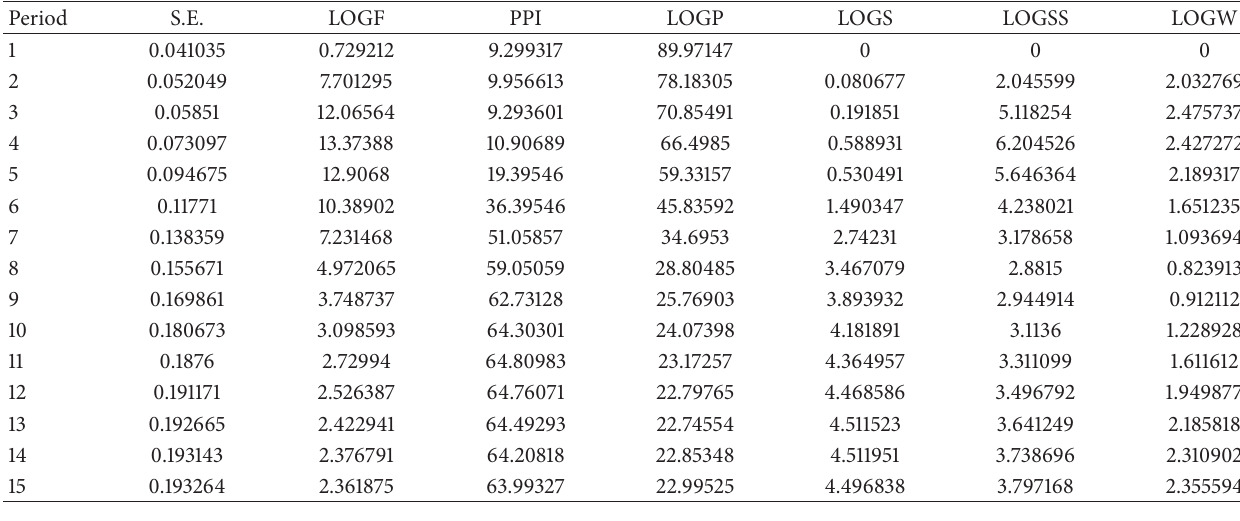
Table 4: Variance decomposition analysis.